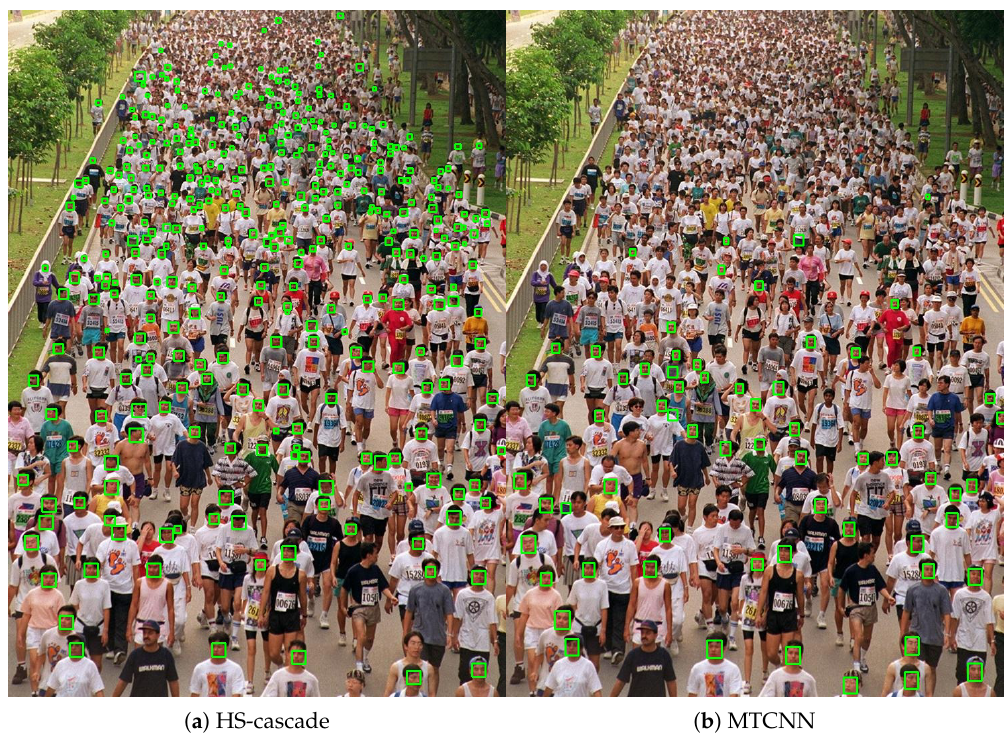
Figure 15. Comparison between HS-cascade and MTCNN (Example